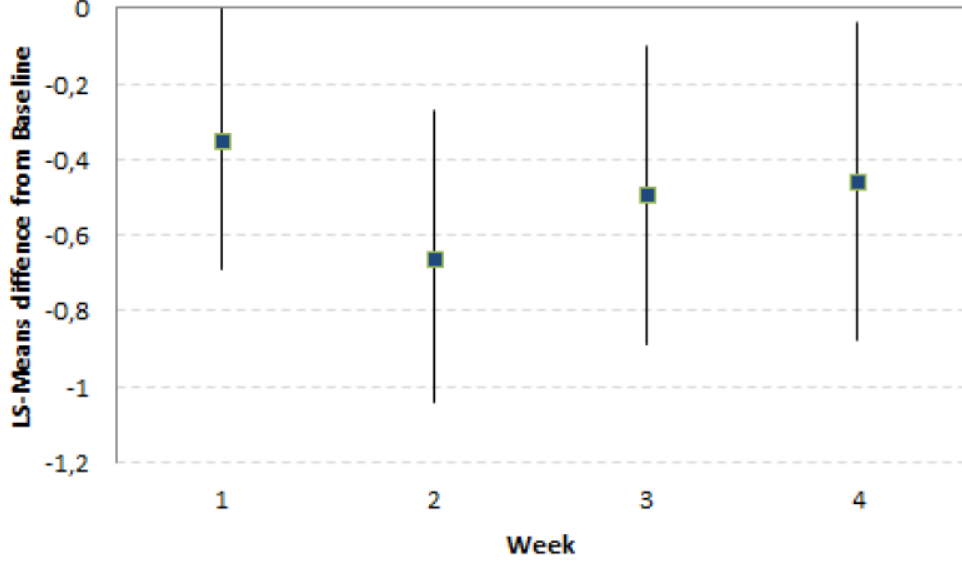
Figure 1. LS-Means differences and 95% confidence interval (CI) (FMP–Control) from Baseline of composite score of digestive symptoms by week ( N = 535).